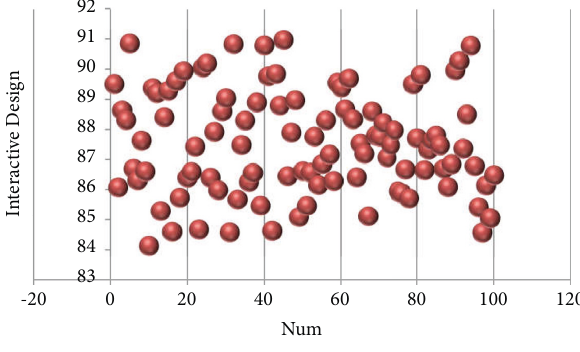
Figure 13: Interaction design